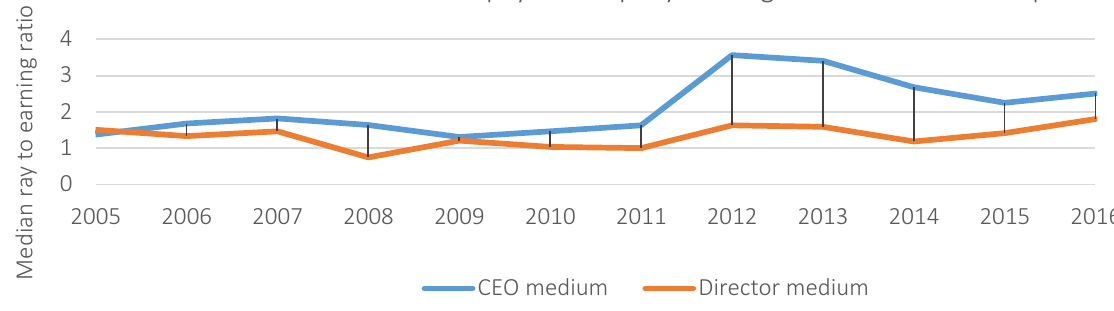
Figure 4. Pay to earnings ratio in medium companies